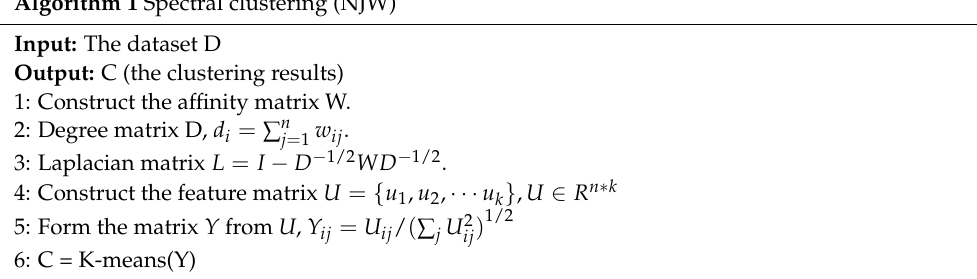
Algorithm 1 Spectral clustering